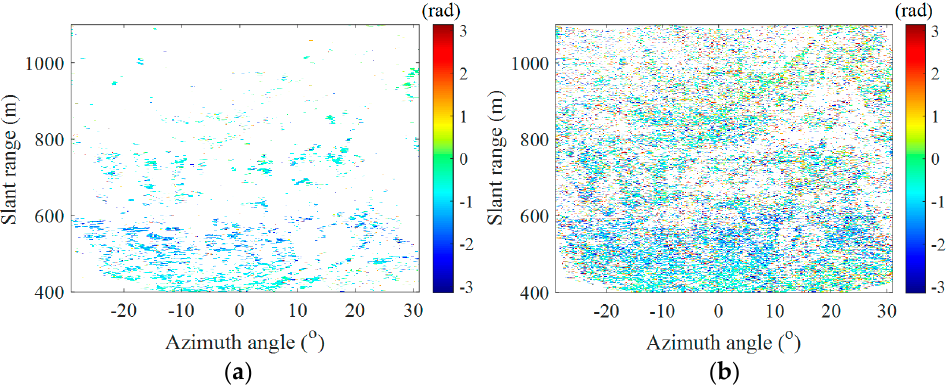
Figure 11. ( a ) Phase map of the reference permanent scatterers (PSs) based on IM 1 − 2 ; ( b ) phase map of the pixels belonging to CS QPS (candidate set of the quasi-permanent scatterers). These reference PSs are divided into 70 clusters, as shown in Figure 12a. Those black squares denote the cluster centers, and every polygon marks the boundary of every cluster. With an inverse distance weighting interpolation, the spatial phase components of the pixels belonging to CS QPS are estimated, as shown in Figure 12b. It is worth noting that the estimated phases vary regularly both along the range and azimuth direction. For the phase components along the range direction, they are caused by the atmospheric disturbance at different times. While for the components along the azimuth direction, published the mechanical track [19].